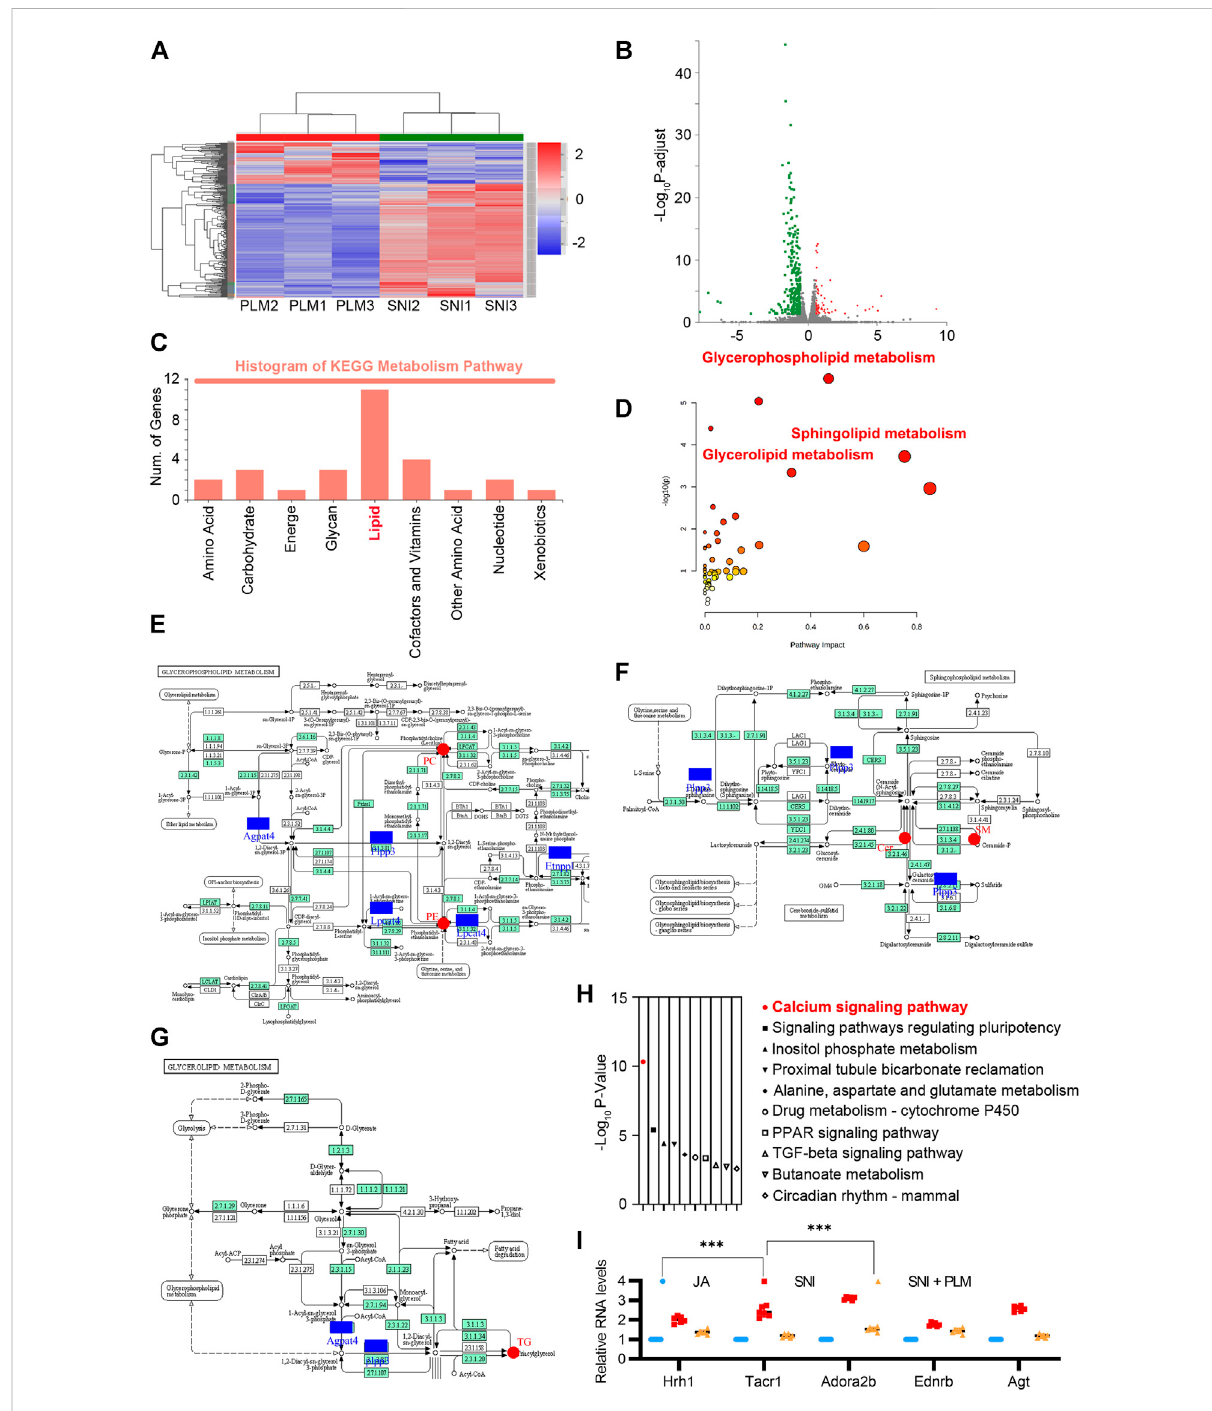
FIGURE 5 (A) HeatmapanalysisofSNIandPLMintranscriptomicanalysis(foldchange > 2). (B) VolcanomapofthedifferentiallyexpressedgenesofSNIand PLM (fold change > 2). (C) KEGG enrichment analysis of downregulated genes upon PL treatment. (D – G) Lipidomics-transcriptomics network built using MetPA. (H) GO enrichment analysis of downregulated genes upon PL treatment. (I) Relative mRNA expression of Hrh1, Tacr1, Adora2b, Ednrb, and Agt in the calcium signaling pathway detected by quantitative RT-PCR assays. SNI, spared nerve injury group; PLM, middle dose of paeoni fl orin and liquiritin combination